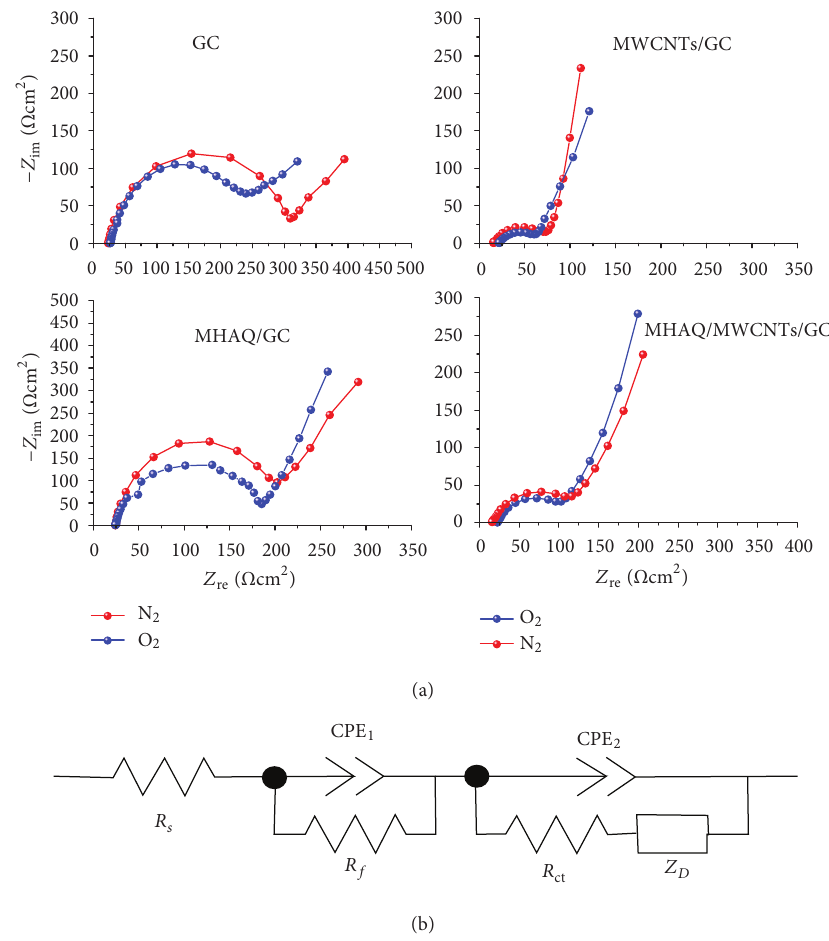
F 8: (a) Nyquist plots obtained from EIS measurements in pH 7.0 N - and O -saturated solutions on the bare GC, MWCNTs/GC, MHAQ/GC, and the MHAQ/MWCNTs nanohybrid modi�ed GC electrodes at a cathodic polari�ation potential of equivalent circuit